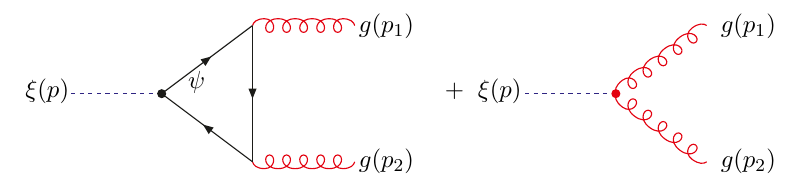
Figure 2 . Feynman diagrams for the 3-point 1PI amplitude of axion ( (cid:24) ) and SU( N c ) gauge bosons ( g ). The fermion loop involves either the derivative couplings c